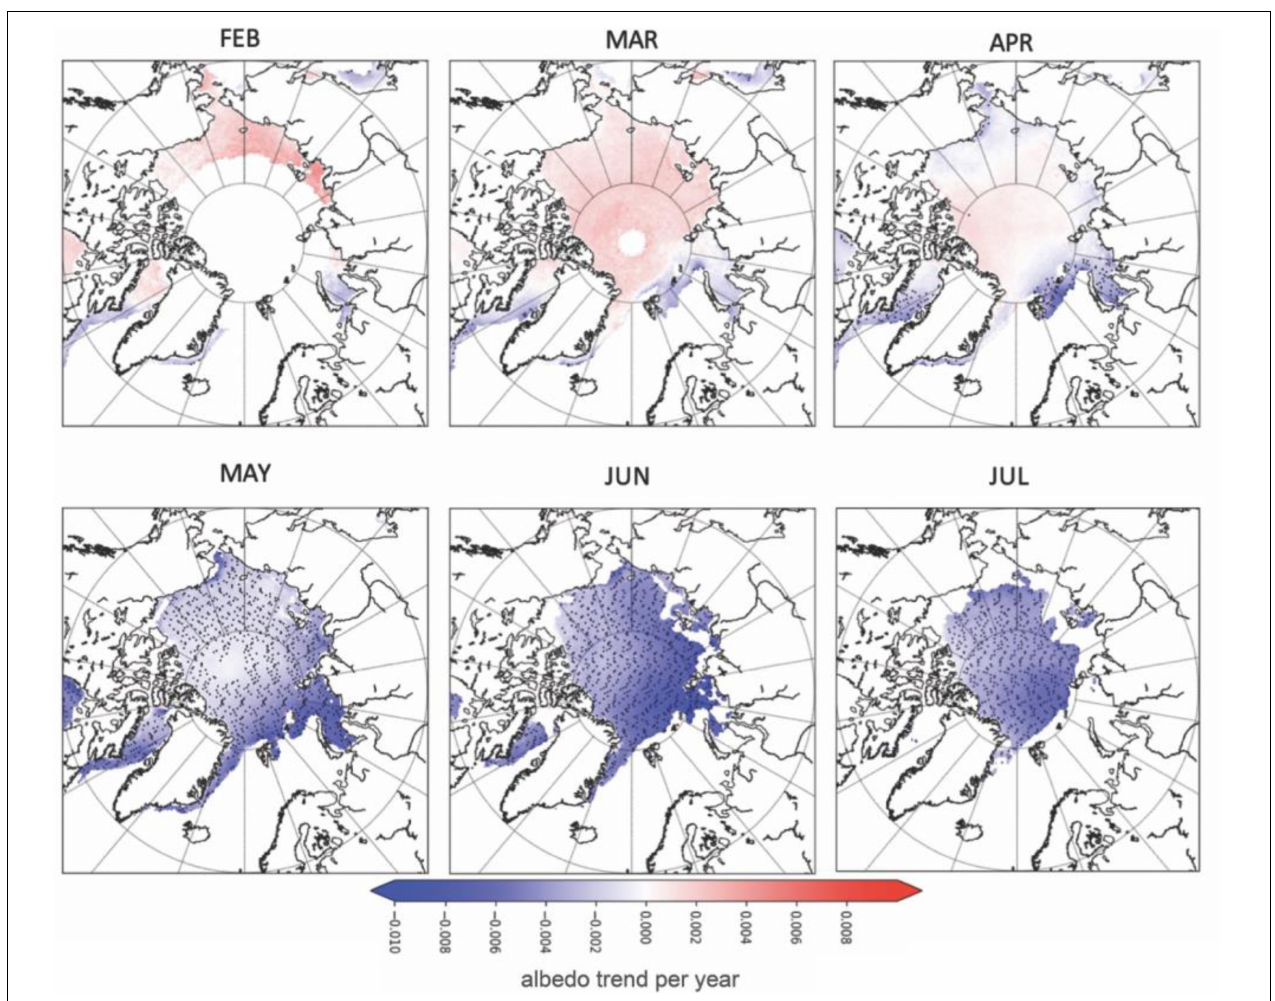
FIGURE 14 | Albedo trends per year in February through July from 1982 to 2018 over Arctic sea ice as derived from AVHRR. Note albedo trends are given for open water as well as ice-covered regions and thus large negative trends along the ice margins reflect in part earlier development of open water, while trends over the icepack in summer reflect also melt pond development. Trends statistically significant at the 95% confidence level are indicated by black